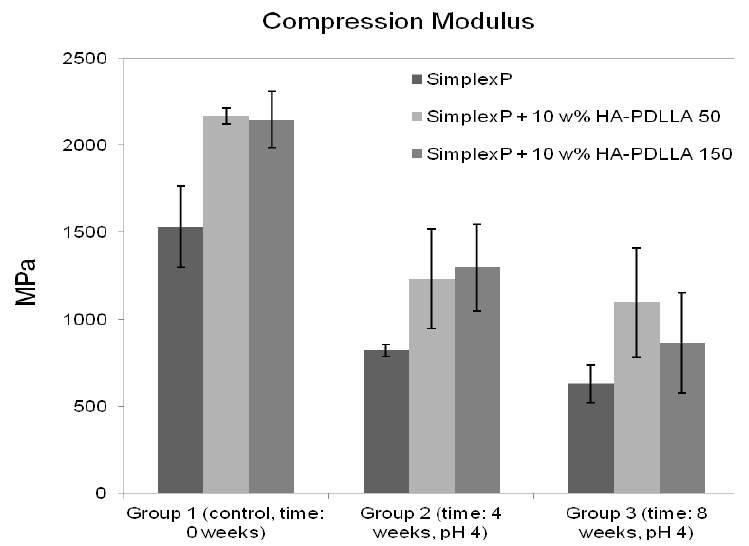
Figure 15. Mean ( ± SD) compression modulus of standard (Simplex P) and modified bone cements tested before (control) and after immersion in an acidic solution (pH = 4) for 4 and 8 weeks.